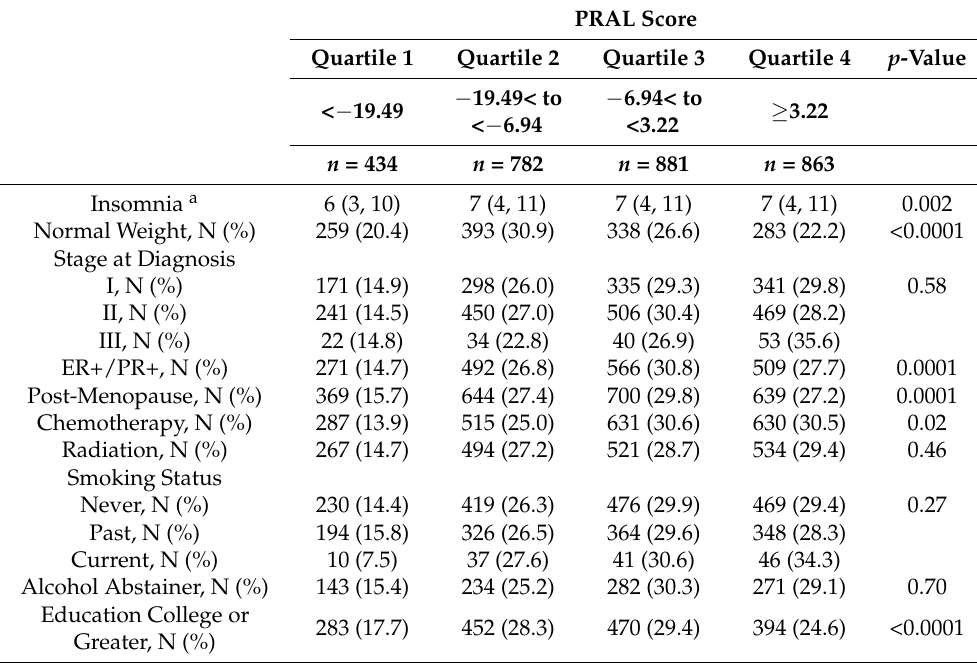
Table 4. Baseline characteristics according to PRAL score in the WHEL study ( n =